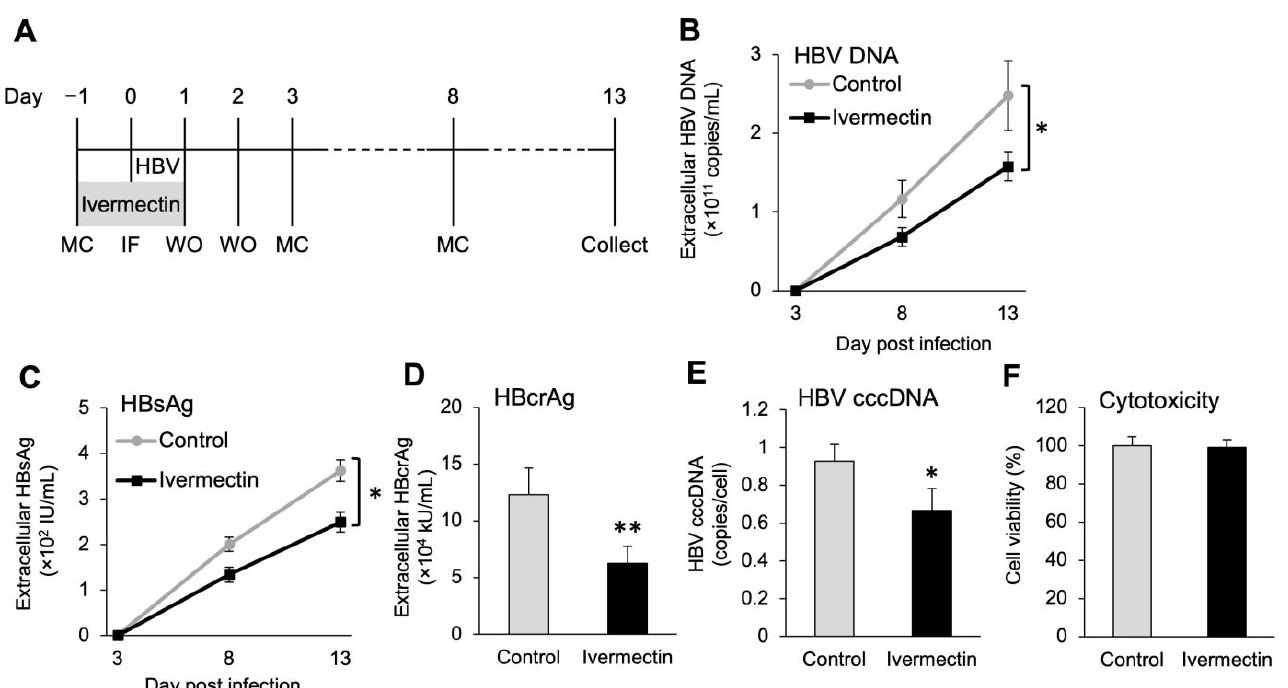
Figure 2. Ivermectin inhibited HBV production in PXB hepatocytes. ( A ) Experimental scheme for ivermectin exposure in the early stages of HBV infection. PXB hepatocytes were treated with 10 μM